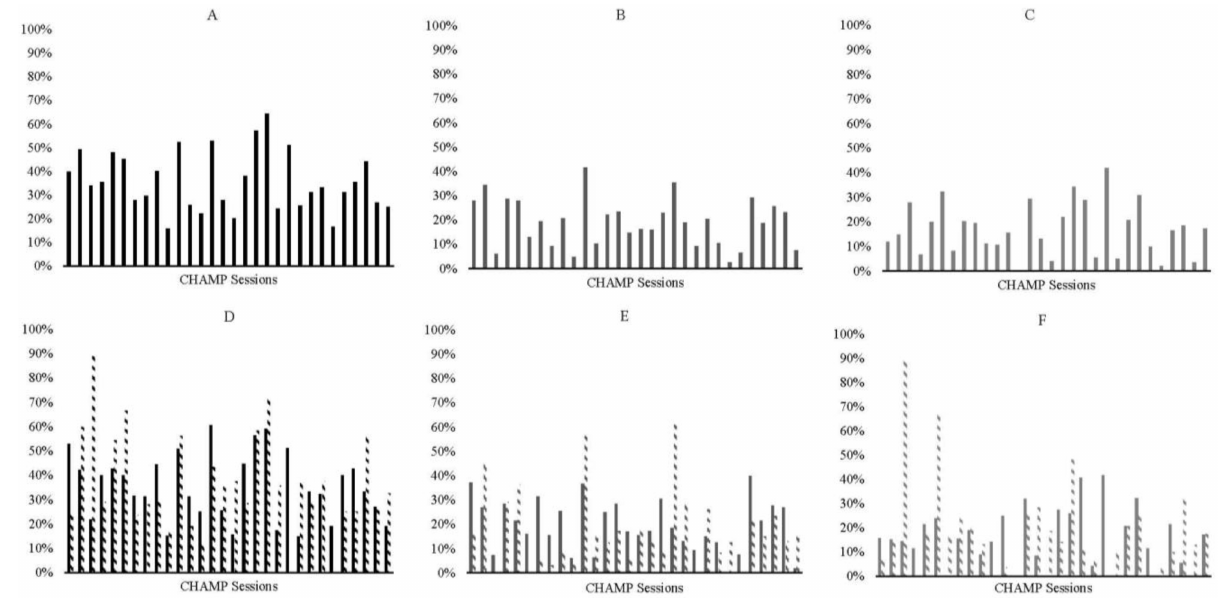
Figure 3. Graphs representing all girls’ engagement across the 30-intervention sessions. In all plots, percentage of engagement is plotted on the y-axis and session number if on the x-axis. Plots include ( A ) all skills, ( B ) locomotor skills, ( C ) ball skills, ( D ) all skills for children with below average initial skills and average and above average initial skills, ( E ) locomotor skills for children with below average initial skills and average and above average initial skills, and ( F ) ball skills for children with below average initial skills and average and above average initial skills. For graphs ( D – F ), children with below average initial skills are plotted in solid bars and children in average & above average initial are plotted in dashed